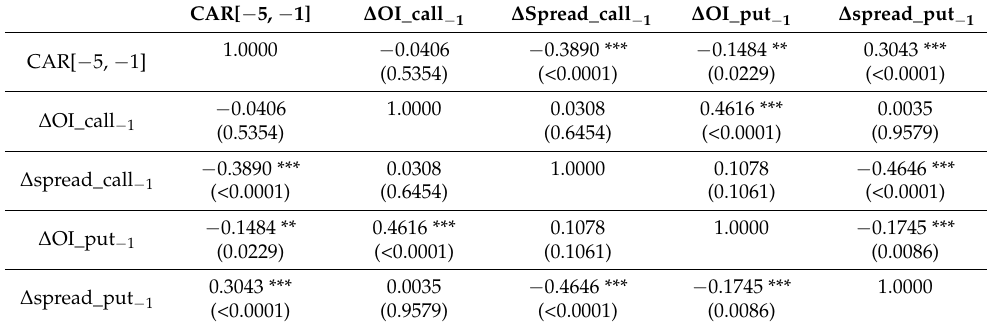
Table 5. Correlation between pre-offer CAR, change in open interest, and change in spread. CAR[ − 5, − 1] ∆ OI_call − 1 ∆ Spread_call − 1 ∆ OI_put − 1 ∆ spread_put − 1 1.0000 − 0.0406 − 0.3890 *** − 0.1484 ** 0.3043 *** CAR[ − 5, − 1] (0.5354) (<0.0001) (0.0229) (<0.0001) − 0.0406 1.0000 0.0308 ∆ OI_call − 1 (0.6454) (<0.0001) − 0.3890 *** ∆ spread_call − 1 − 0.1484 ∆ OI_put − 1